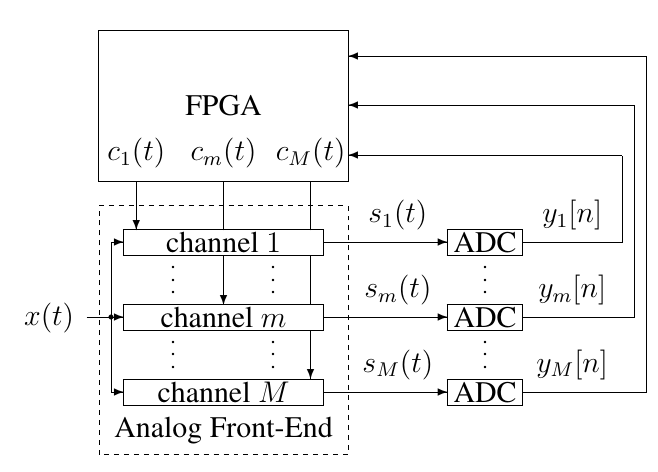
Figure 3. System block diagram.